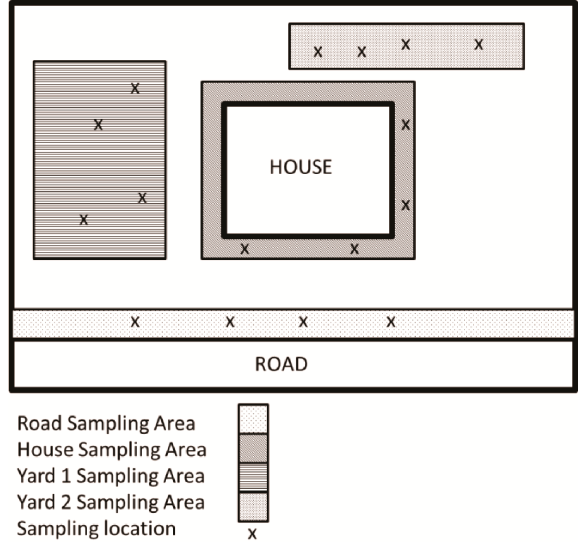
Figure Figure 5. Schematic of the soil sampling strategy for selected residences in the Stambaugh-Elwood community.